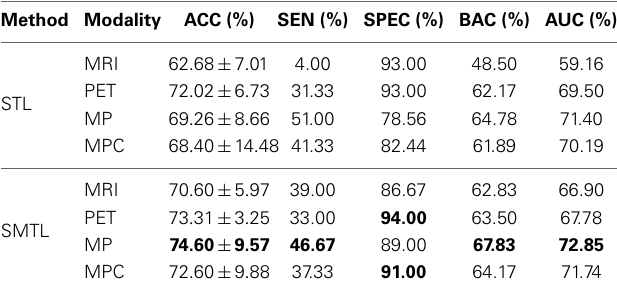
(STL, Single-Task Learning, SMTL, Subclass-based Multi-Task Learning). The boldface denotes the best performance in each